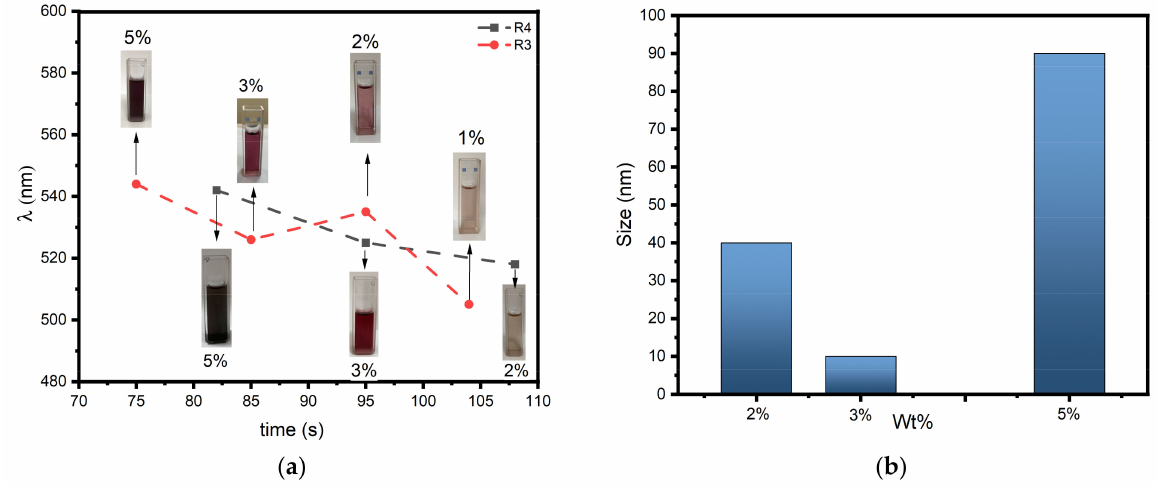
Figure 3. The salts HAuCl 4 are prepared at different ( w / w ) (1%, 2%, 3%, 5%) ( a ) and comparison between different sizes of gold nanoparticles ( b